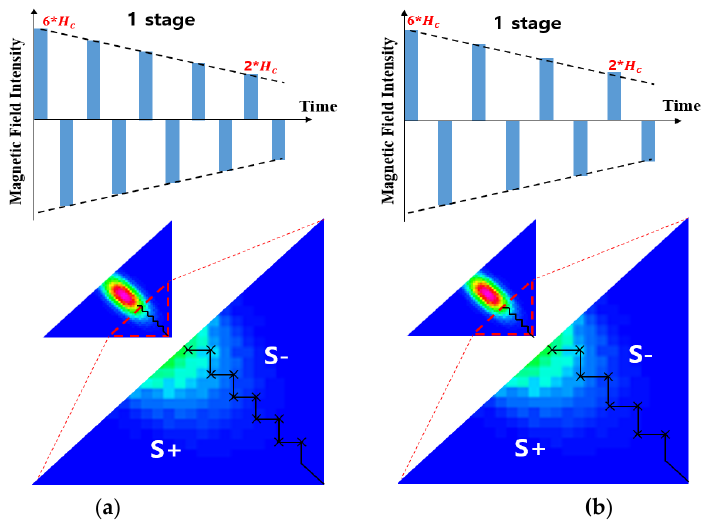
Figure 6. The traces of the Preisach plane in Stage 1 of the proposed protocols: ( a ) 10 magnetic fields; ( b ) 8 magnetic fields.